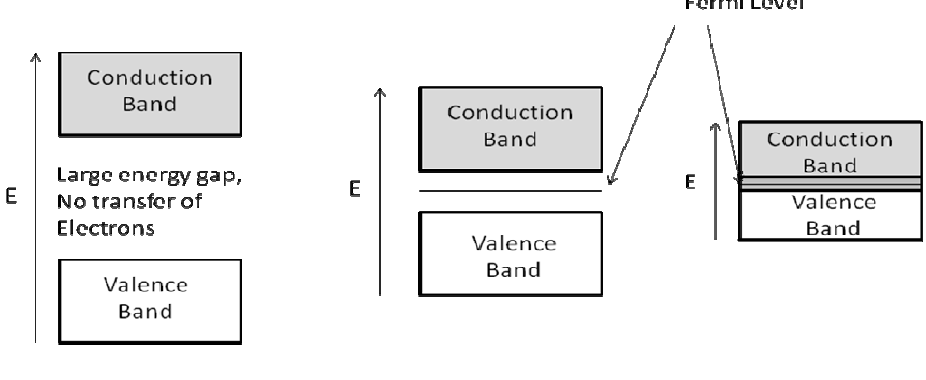
Figure 1. Schematic band diagrams of an insulator, semi-conductor and conductor—Note the small gap in the semiconductor, where electrons with sufficient energy can cross and the overlapping of the bands in the